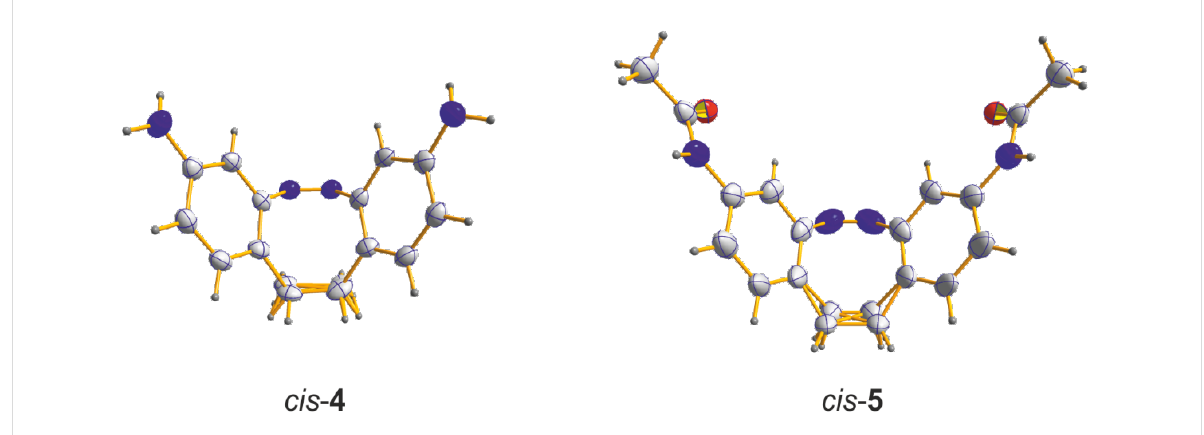
Figure 2: Crystal structures of the cis isomers of 3,3’-diamino-EBAB 4 and its acetamide derivative 5 . The atoms of the ethylene bridge are disor- dered.